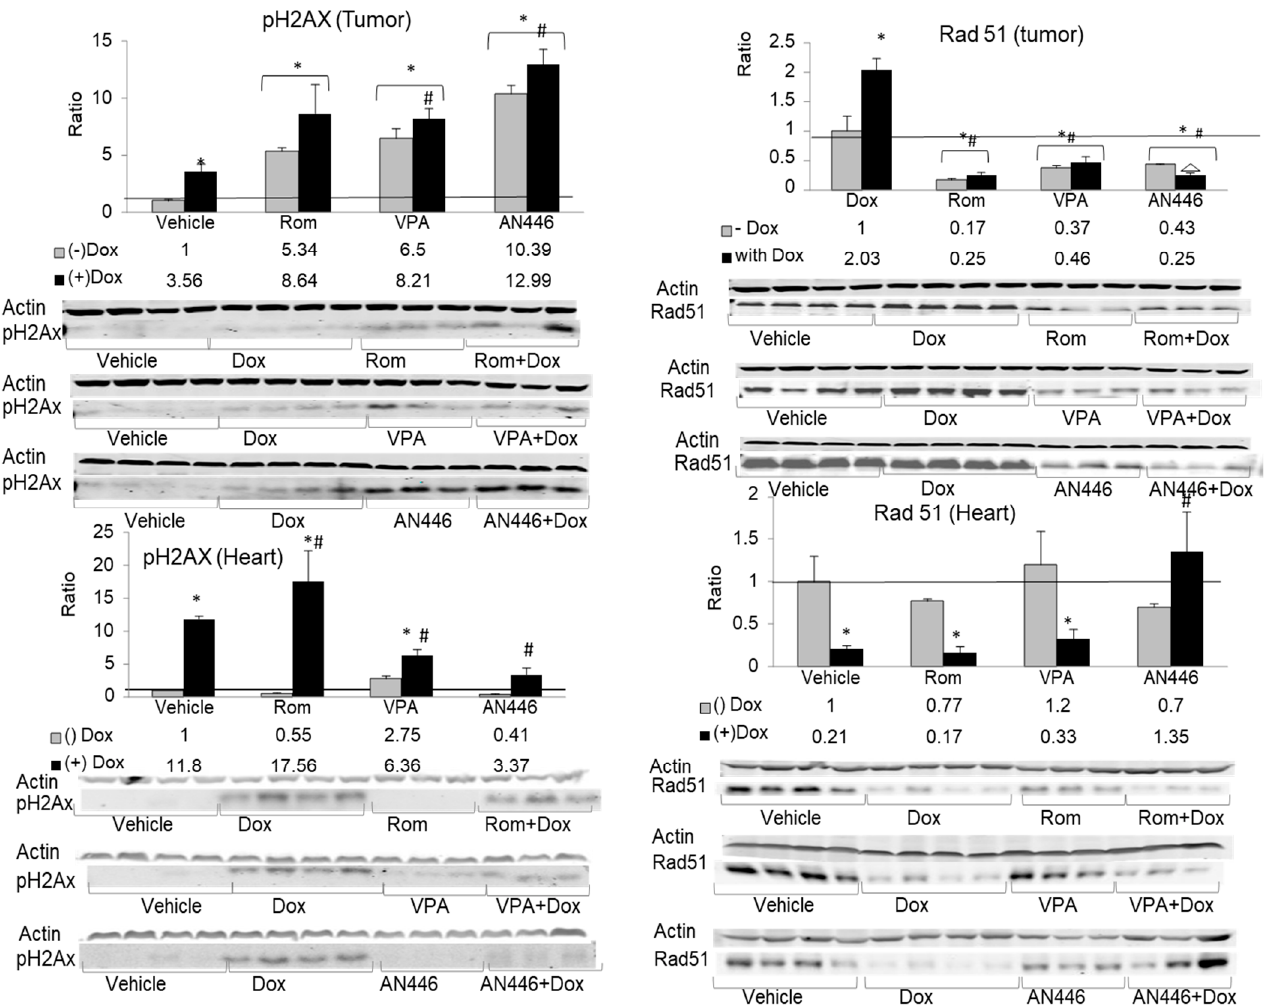
Figure 6. Effect of the treatments on DNA damage and repair response. Lysate samples for detection of DNA DSBs were stained for γ H2AX ( left ‐ hand side) and the markers for the detection of RAD51 were stained for anti ‐ RAD51 ( right ‐ hand side); The peptides were resolved on 15% SDS gel. Fold increase was determined as described in Figure 5 above. * p < 0.05 all drug ‐ treated vs. vehicle ‐ treated mice; # p < 0.05 Dox ‐ treated vs. drug ‐ treated mice.